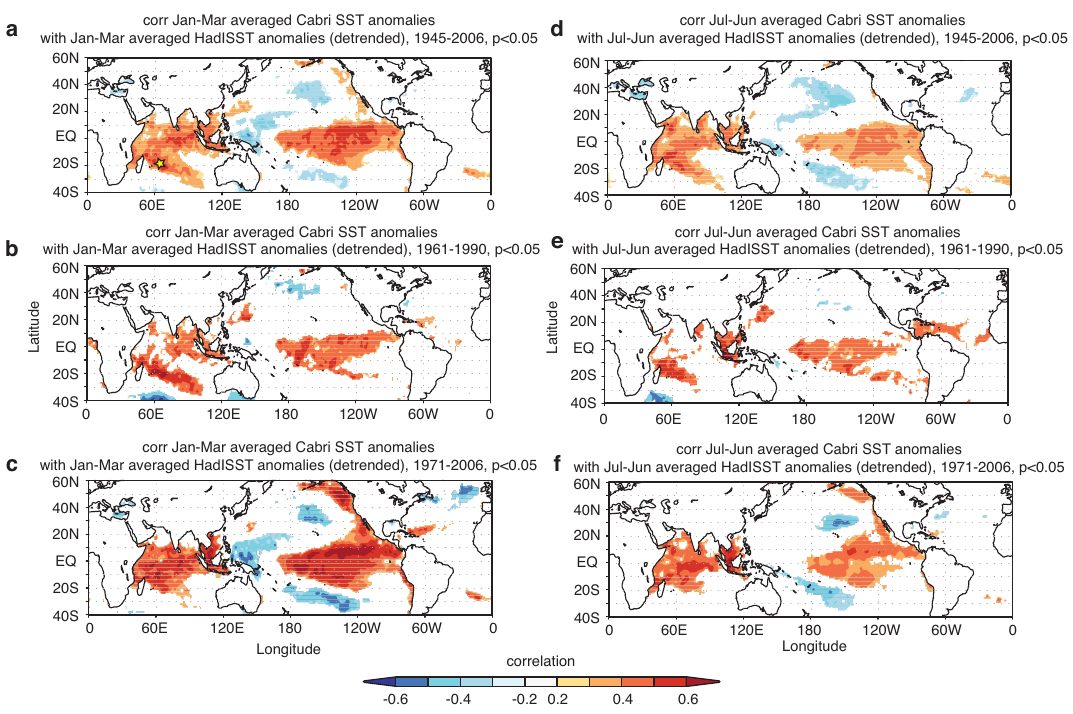
Figure 6. Spatial correlation of Cabri Sr / Ca–SST anomalies (relative to 1961–1990) with HadISST (Rayner et al., 2003). January to March austral summer in (a) between 1945–2006, (b) 1961–1990 and (c) 1971–2006. Annual mean correlations in (d) between 1945–2006, (e) 1961–1990 and (f) 1971–2006. Only correlations with p <0.05 are coloured. Computed at KNMI Climate Explorer (van Oldenborgh and Burgers, 2005). Yellow star in (a) marks location of Rodrigues